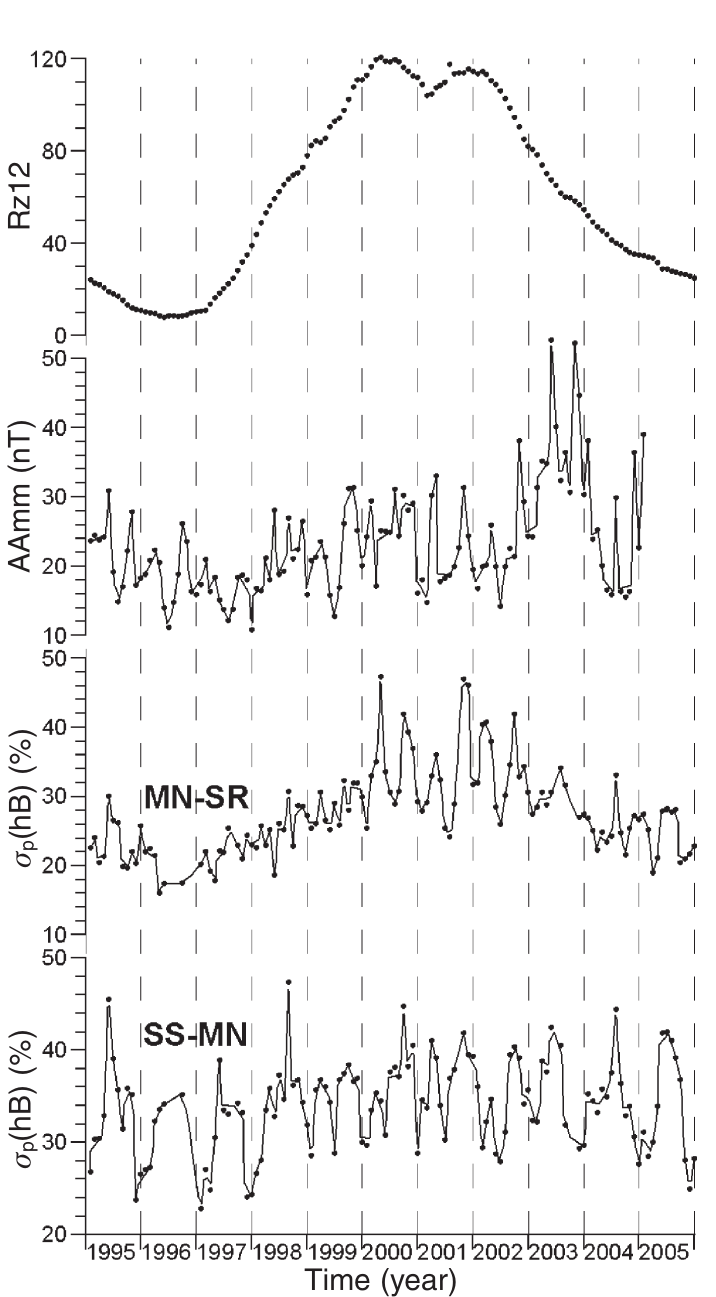
Fig. 10. Long-term dependence of the σ p(h) from 1995 to 2005. From top to bottom: yearly smoothed monthly means of sunspot numbers Rz12, yearly smoothed monthly means of geomagnetic activity index AA, average of σ p(h) from midnight to sunrise (MN-SR), and from sunset to midnight (SS-MN) respectively (Altadill, 288